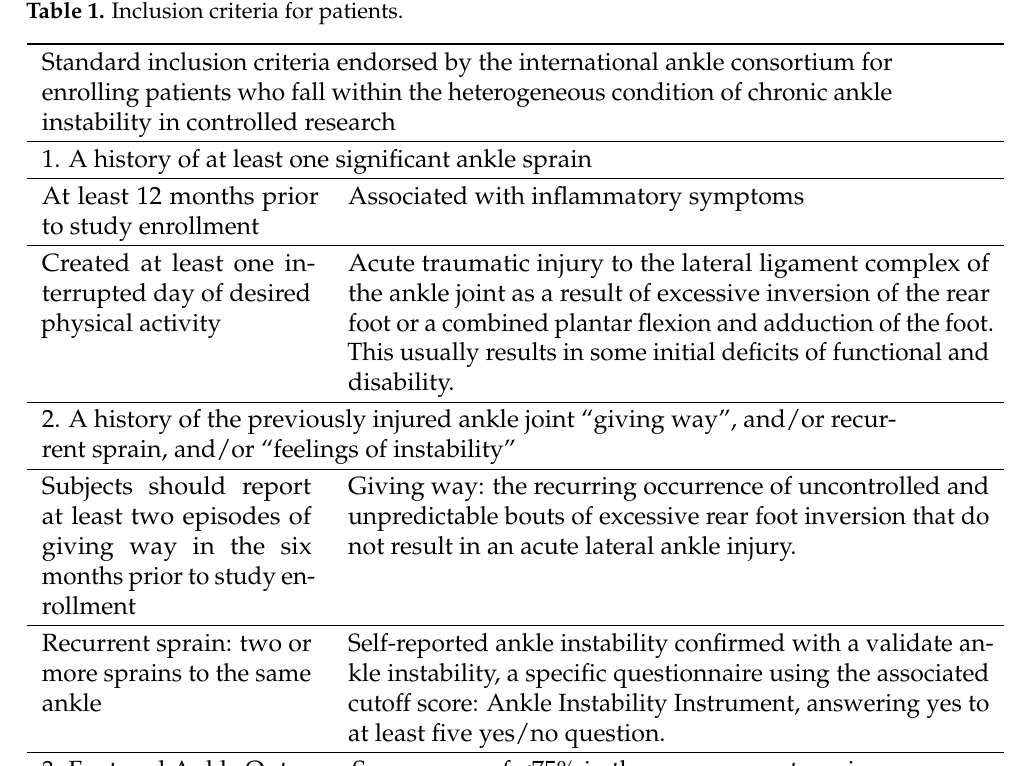
Table 1. Inclusion criteria for patients.